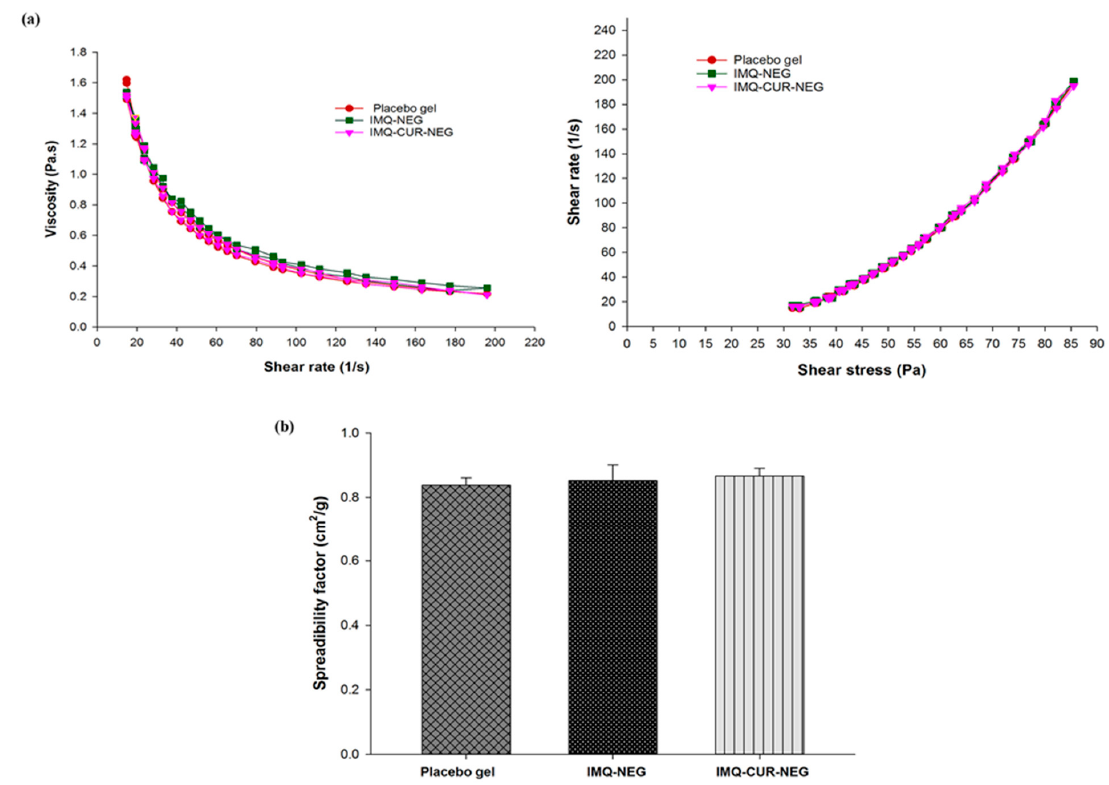
Figure 6. ( a ) Rheological behavior of placebo gel, IMQ-NEG, and IMQ-CUR-NEG. ( b ) The spreadability factors of the placebo gel, IMQ-NEG, and IMQ-CUR-NEG are nearly equal and the difference in the value of the spreadability factor between these three gels was found to be statistically insignificant ( p > 0.05) ( n = 3).